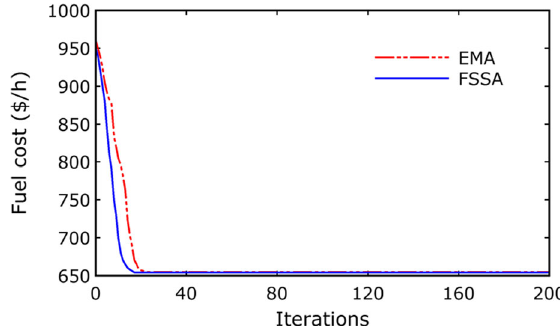
Fig. 12 Convergence comparison of the FSSA